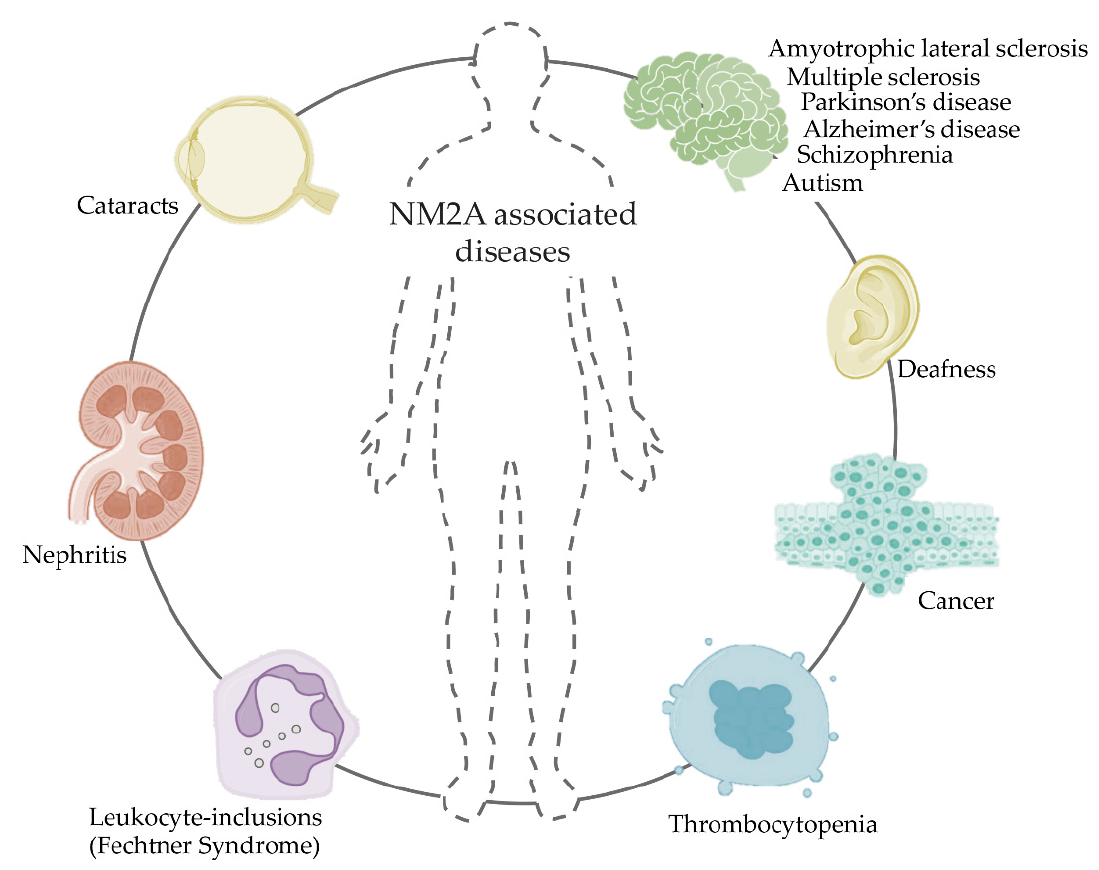
Figure 7. Human pathologies associated with mutations in MYH9 , NM2A expression and / or activity defects. In agreement with the key roles of NM2A from embryo development to adulthood, its malfunction affects several organs causing mild to life-threatening disorders. In particular, NM2A defects were associated with neurodegenerative diseases, cancer, bleeding diseases and kidney inflammation.